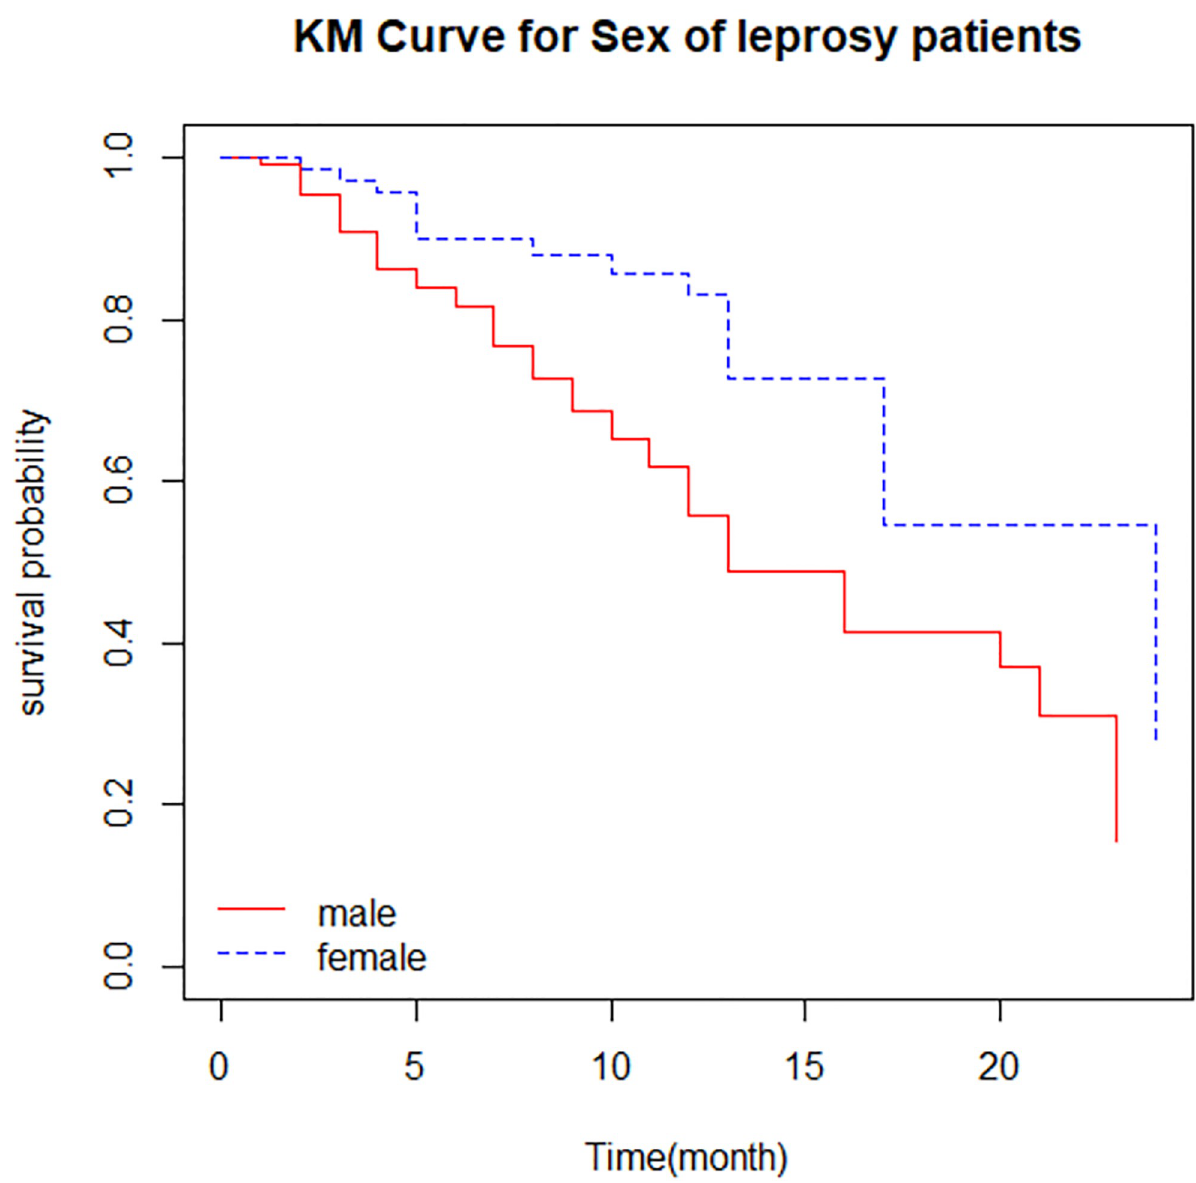
Fig 2. The survival function by sex of leprosy patients.